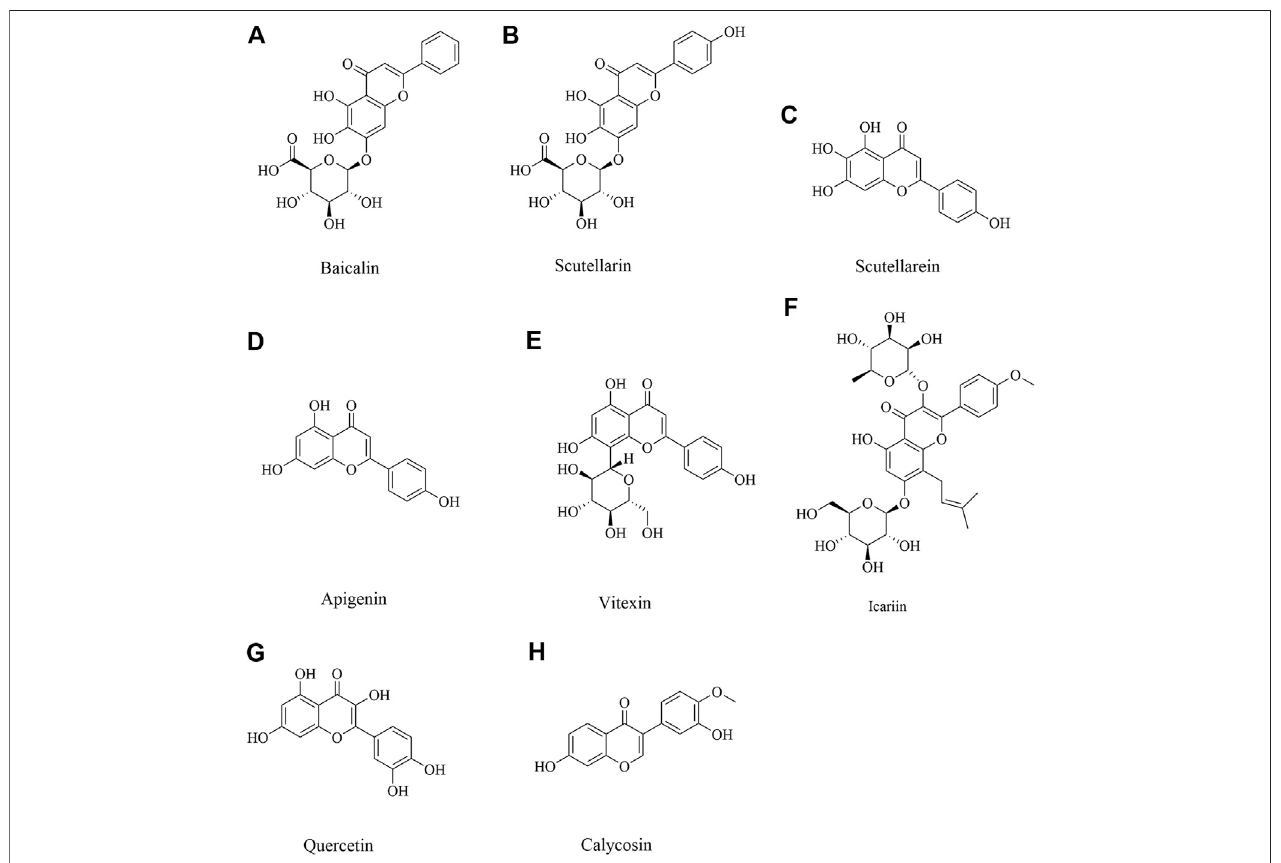
FIGURE 2 | The fl avonoids for cerebral ischemia